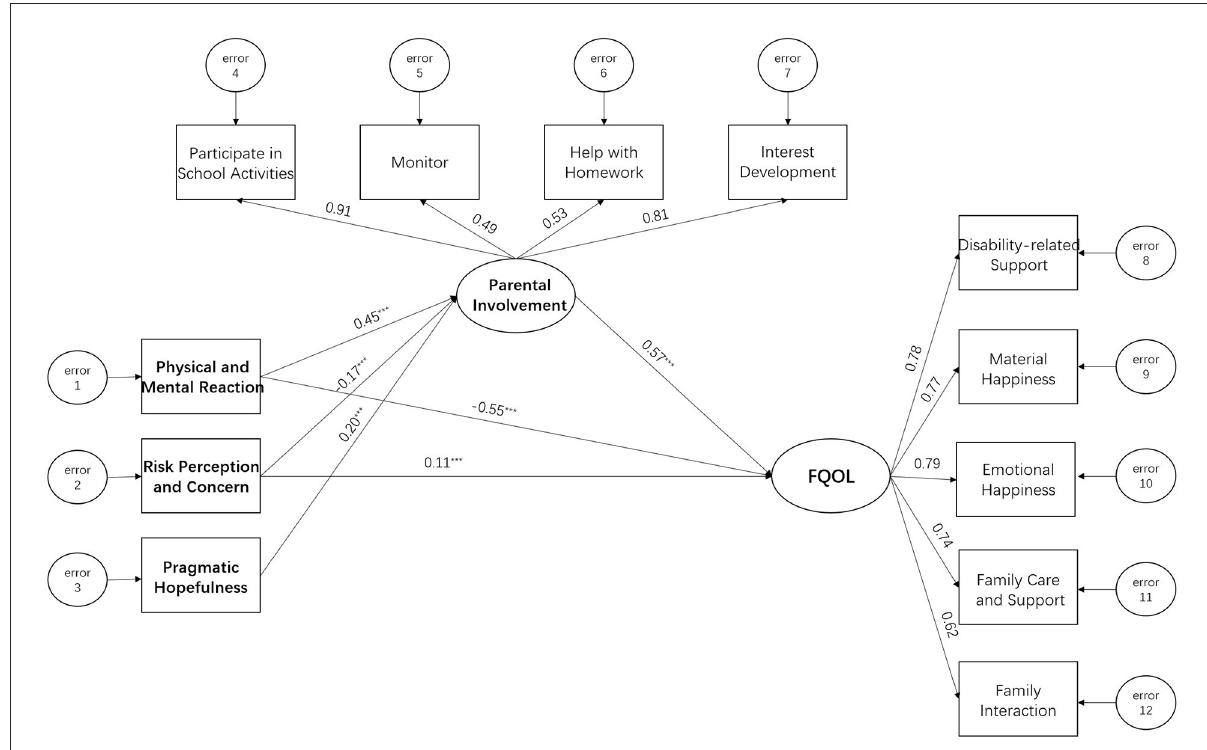
FIGURE4 Structural equation model path diagram of the interrelations between stress, involvement, and FQOL. FQOL, family quality of life. *** p <